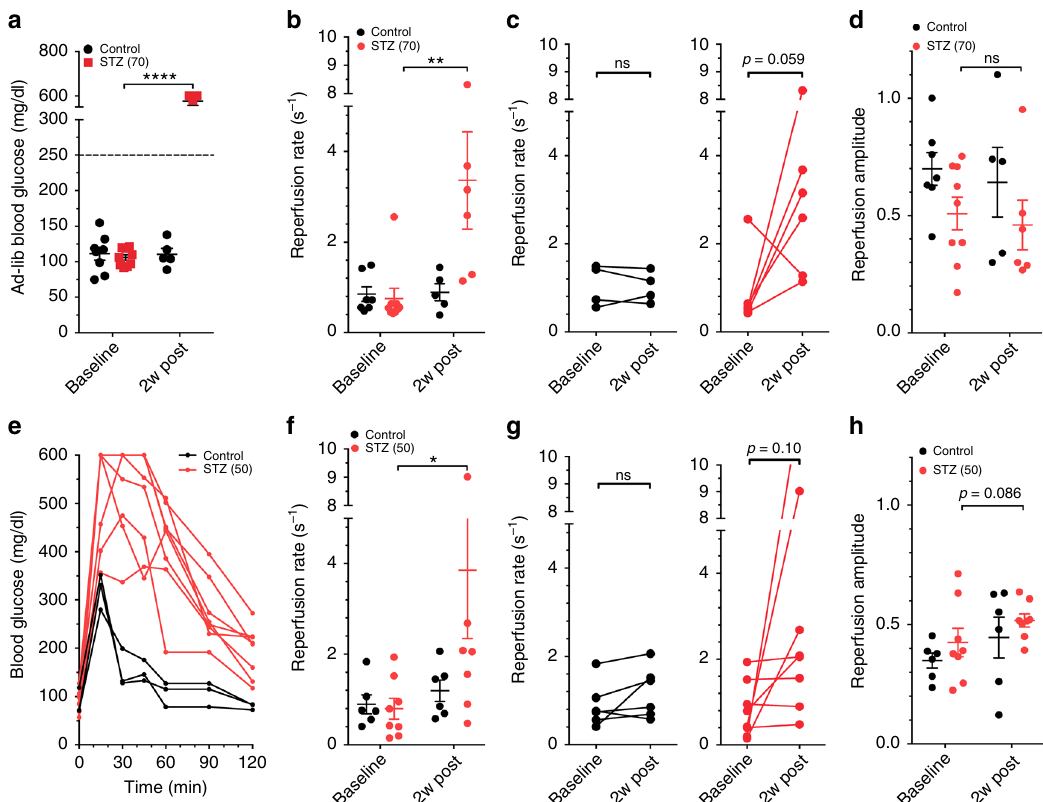
Fig. 2 CEUS non invasively detects changes in the pancreas blood fl ow dynamics following STZ-induced β -cell injury. a Ad-libidum blood glucose concentrations of female C57BL/6 mice injected with 70 mg/kg STZ or buffer (control) before (baseline) and 2 weeks post treatment (2w post). b Reperfusion rate measured in mice in a treated with 70 mg/kg STZ or control before and 2 weeks post treatment. c Data in b showing changes in individual mice for reperfusion rate. d As in b measuring reperfusion amplitude. e Glucose tolerance tests from female C57BL/6 mice 2 weeks following treatment with buffer (control) or 50 mg/kg STZ. f Reperfusion rate measured in mice treated as in e with 50 mg/kg STZ or control before and 2 weeks post treatment. g Data in f showing the changes in individual mice for reperfusion rate. h As in f measuring reperfusion amplitude. Error bars represent s.e.m. * p < 0.05 comparing groups indicated (paired t -test for data in c , g ; ANOVA for data in a , b , d , f , h ). Data in a – d represents n = 6 STZ-treated ( n = 9 at baseline for b , d ) and n = 5 control mice ( n = 7 at baseline for b , d ); data in e represents n = 8 STZ-treated and n = 3 control; data in f – h represents n =